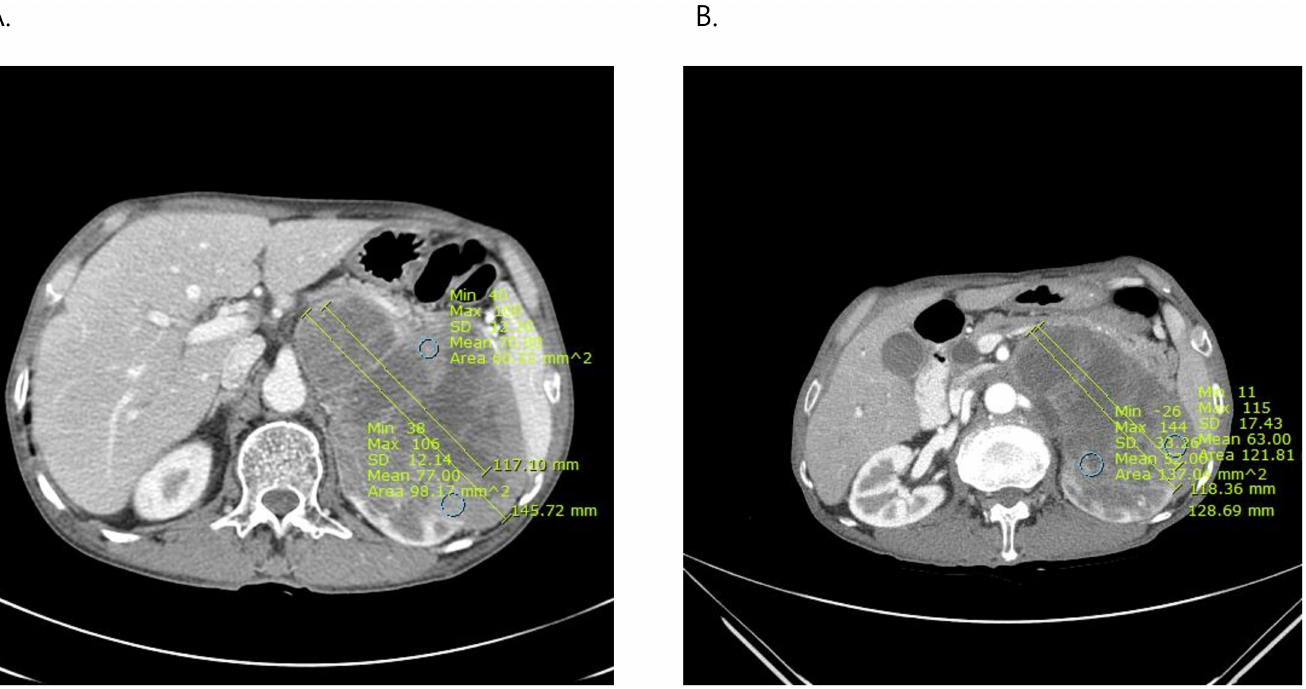
Fig 1. Representative changes of tumor size and necrosis size with attenuation on first follow-up contrast-enhanced computed tomography (CT) scans in metastaticrenal cell carcinoma (RCC) patients with unresectable primary RCC. A. Axial CT image before sunitinibtherapy showed a 14.5 cm-sized enhancing left renal mass with hilar invasionand presenceof venous tumor thrombi. B. Comparedto the CT image before targeted therapy, the CT image after 2-cycles of sunitinibshowedthat the tumor’s size had decreased (12.9 cm) with increasednecrosis (11.8 cm) and decreased attenuation (from 77 Hounsfield units to 52